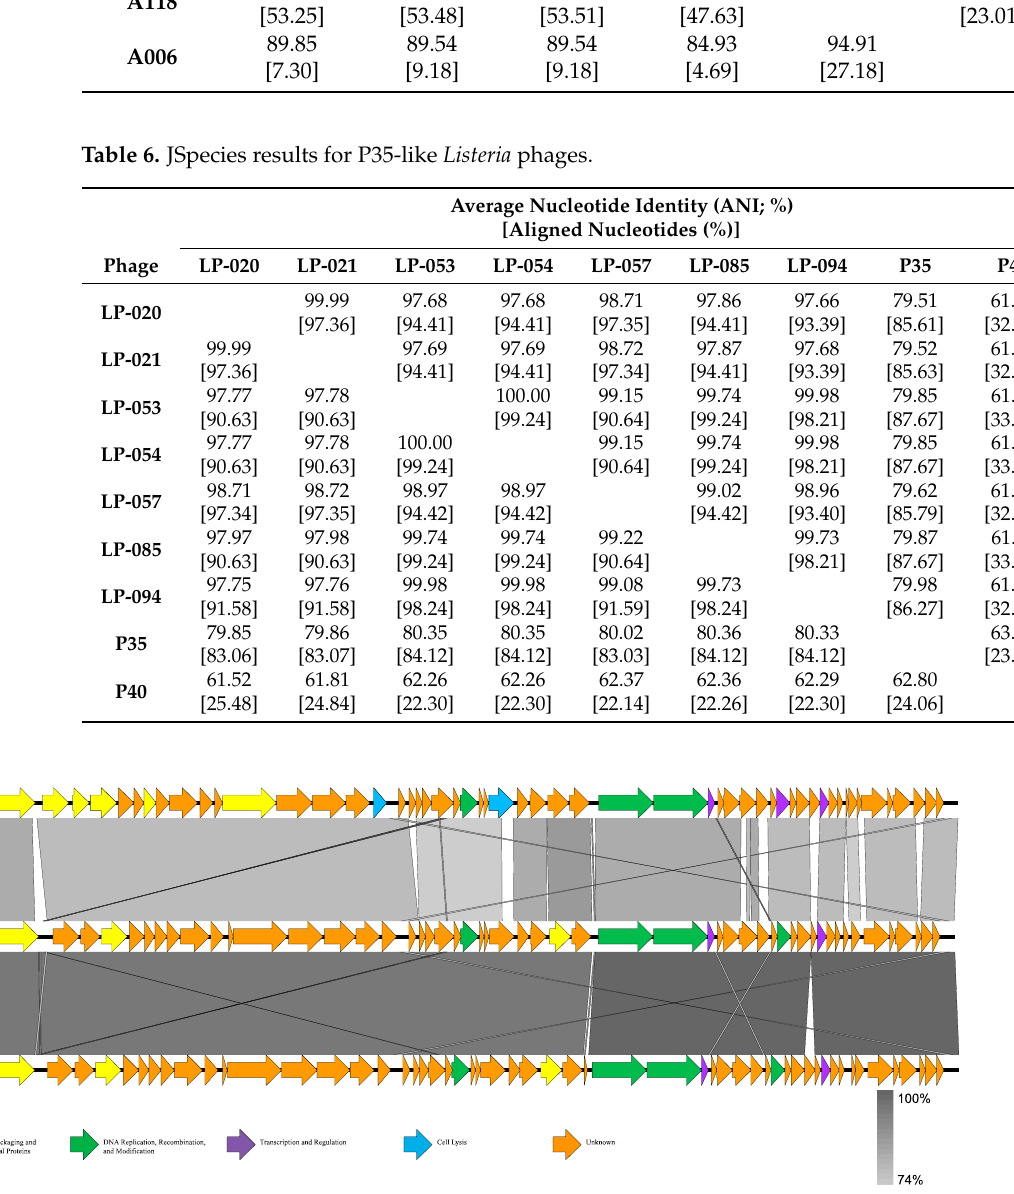
Figure 2. Linear BLASTn comparisons of representative P35-like Listeria phages. Genes are represented by arrows and are colored based on putative function (see key at bottom). The shaded region between genomes represents nucleotide similarity, with the darker gray representing higher similarity and lighter gray indicating lower similarity (see scale at bottom right).